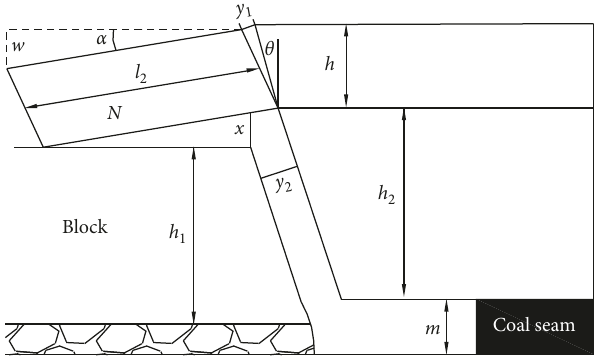
Figure 8: The calculation of overburden strata fissure